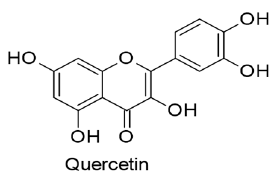
positive primary effusion lymphoma (PEL)